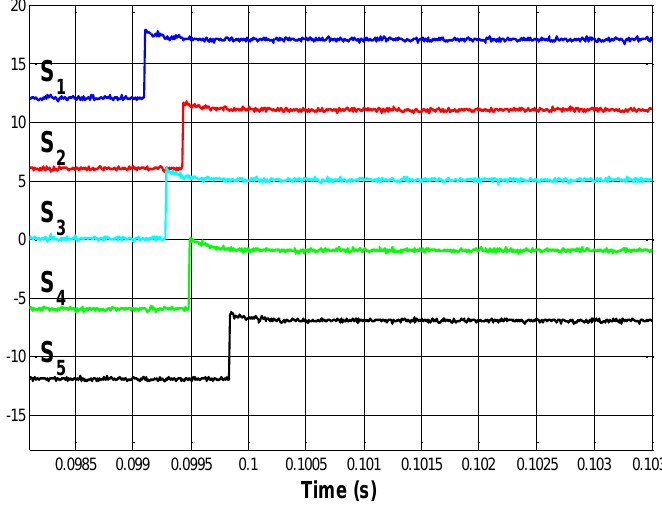
Figure 11. Edge signals when impacting on